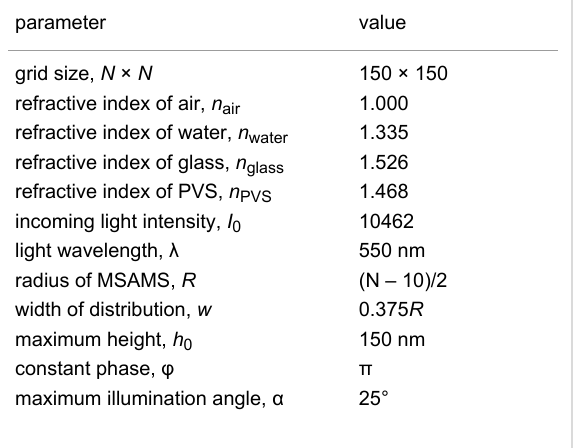
Table 1: Parameter and its values used in the simulation. parameter